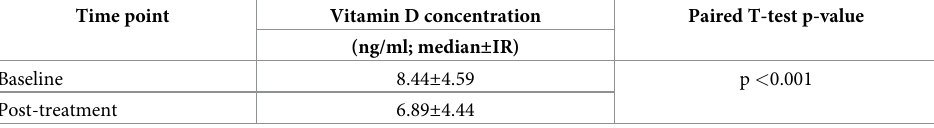
Abbreviation: IR: interquartile ratio; COV: coefficient of